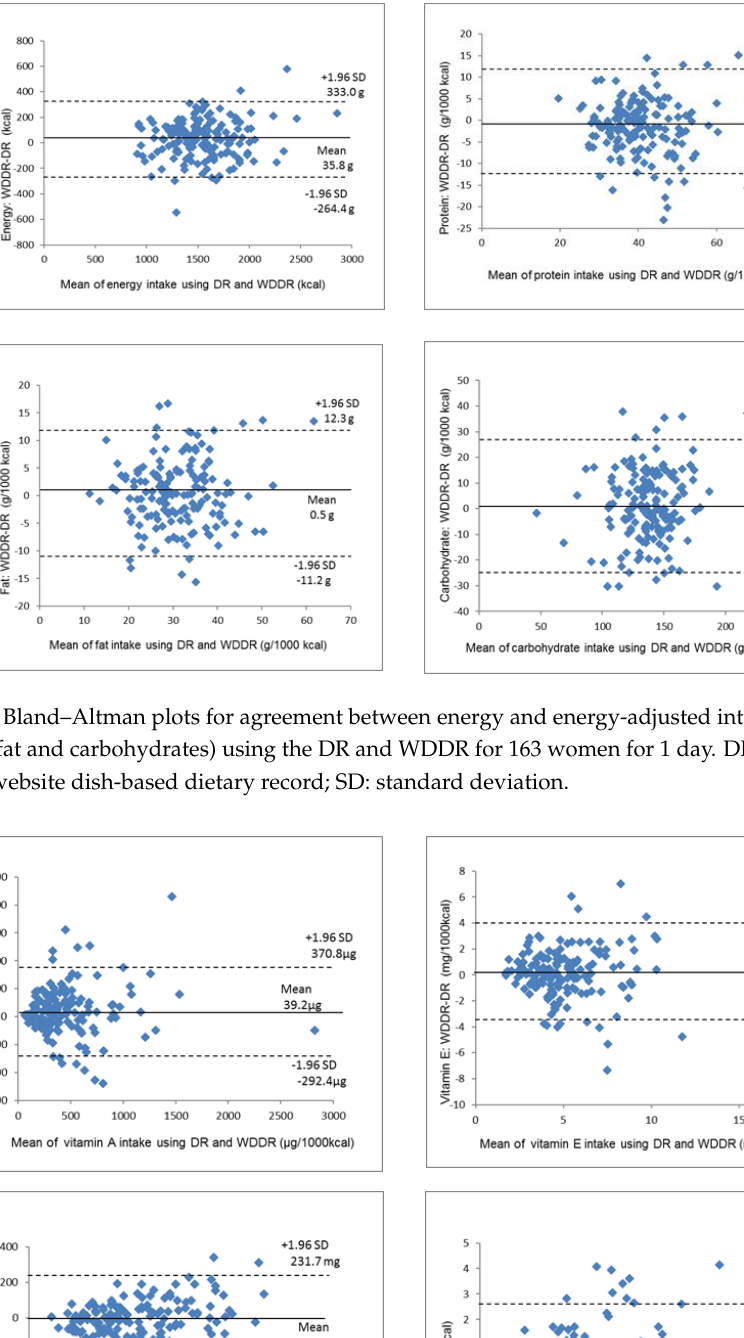
Figure 5. Bland–Altman plots for agreement between energy-adjusted intakes of nutrients (calcium, iron, vitamin A, vitamin E, vitamin B1 and vitamin B2) using the DR and WDDR for 163 women for 1 day. DR: dietary record; WDDR: website dish-based dietary record; SD: standard deviation.